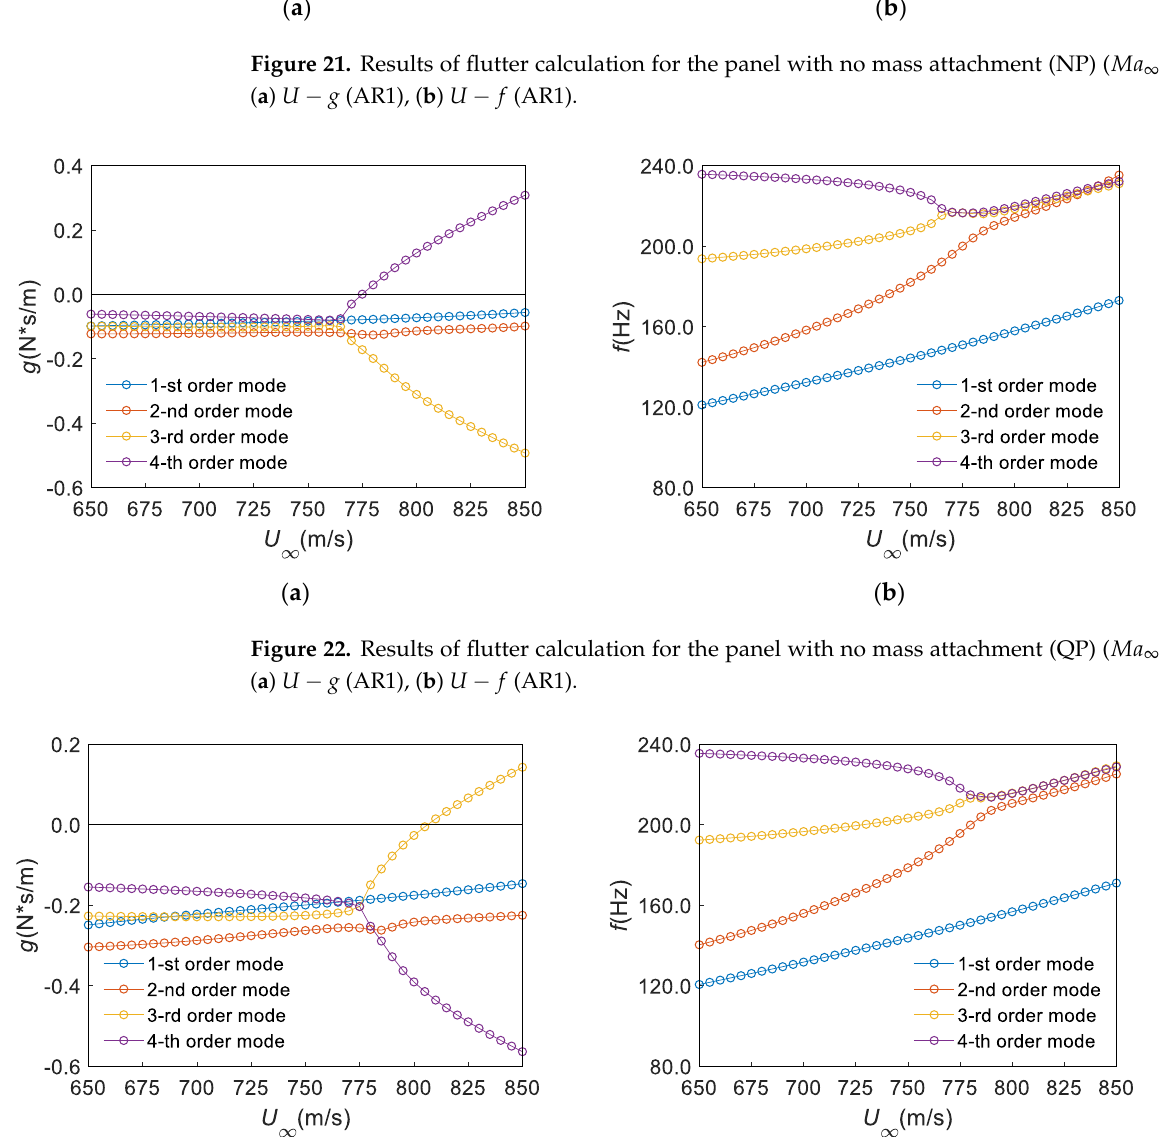
( b ) Figure 24. Results of flutter calculation for the panel with no mass attachment (NP) (